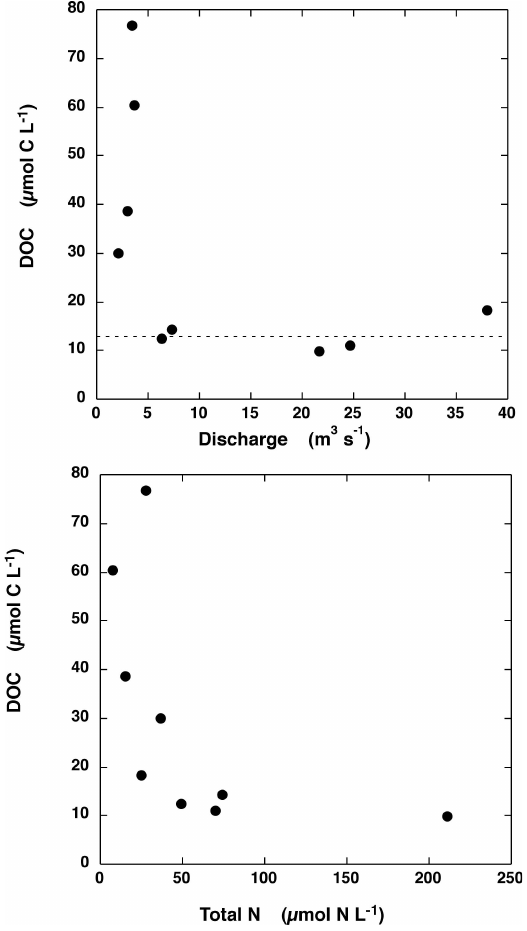
Fig. 1. The relationship between dissolved organic carbon (DOC) concentration and the discharge and total nitrogen concentration in the main discharge (boils) of nine Florida springs. The dotted line shows the mean DOC concentration in springs with discharge > 5m 3 s − 1 , 13.1 ± 1.6µmolCL − 1 , probably representing the DOC concentration in the Floridan aquifer.